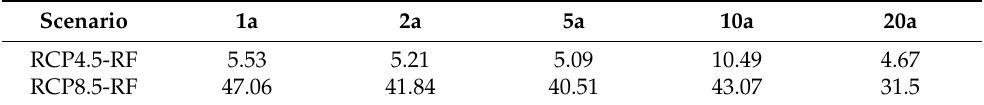
Table 15. Changes of submerged area (unit: